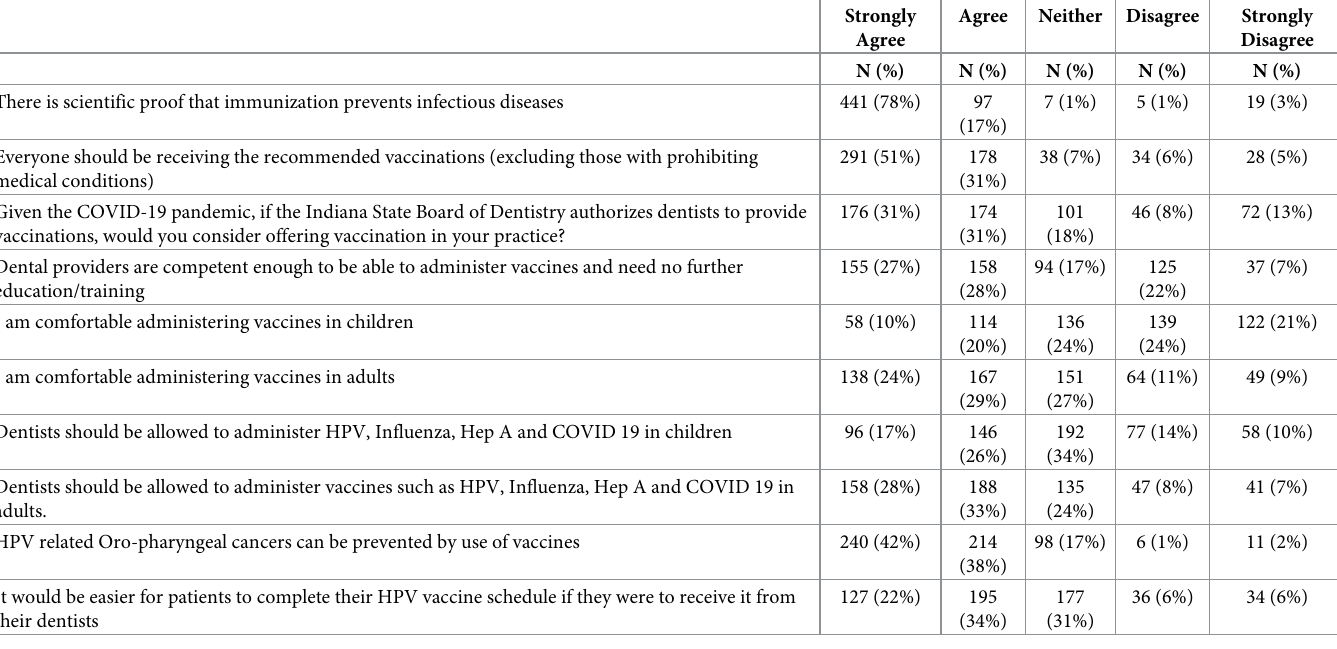
Table 2. Beliefs, attitudes, and comfort levels around